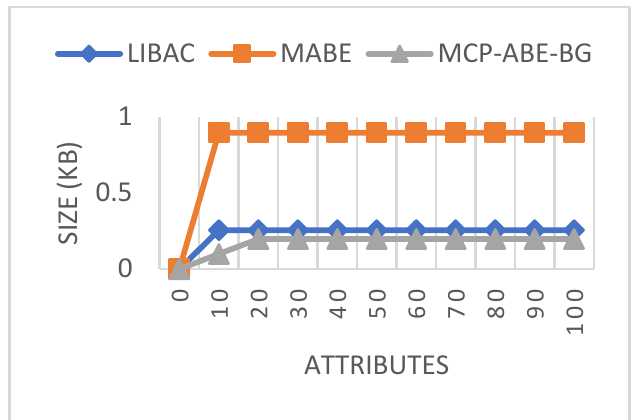
Figure 9. Public key size comparisons.